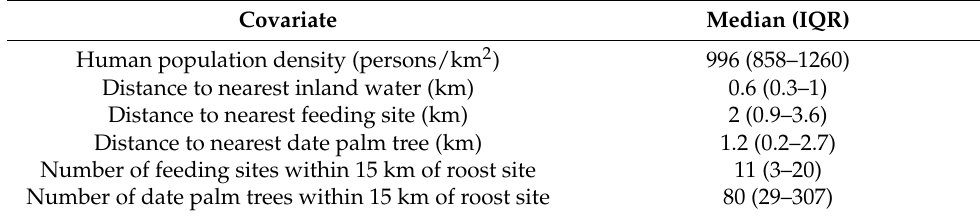
Table 2. Distribution of select spatial covariates across all mapped roost